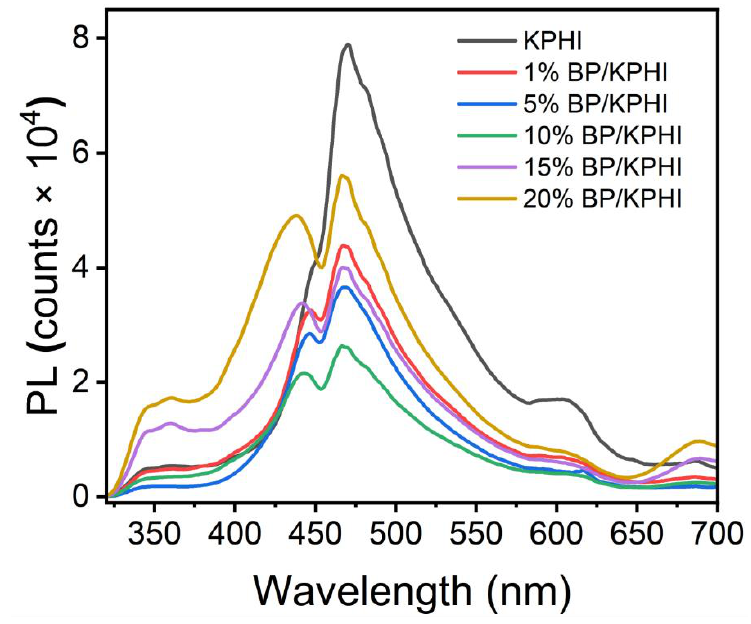
Figure 12. PL spectra of BP/KPHI and KPHI